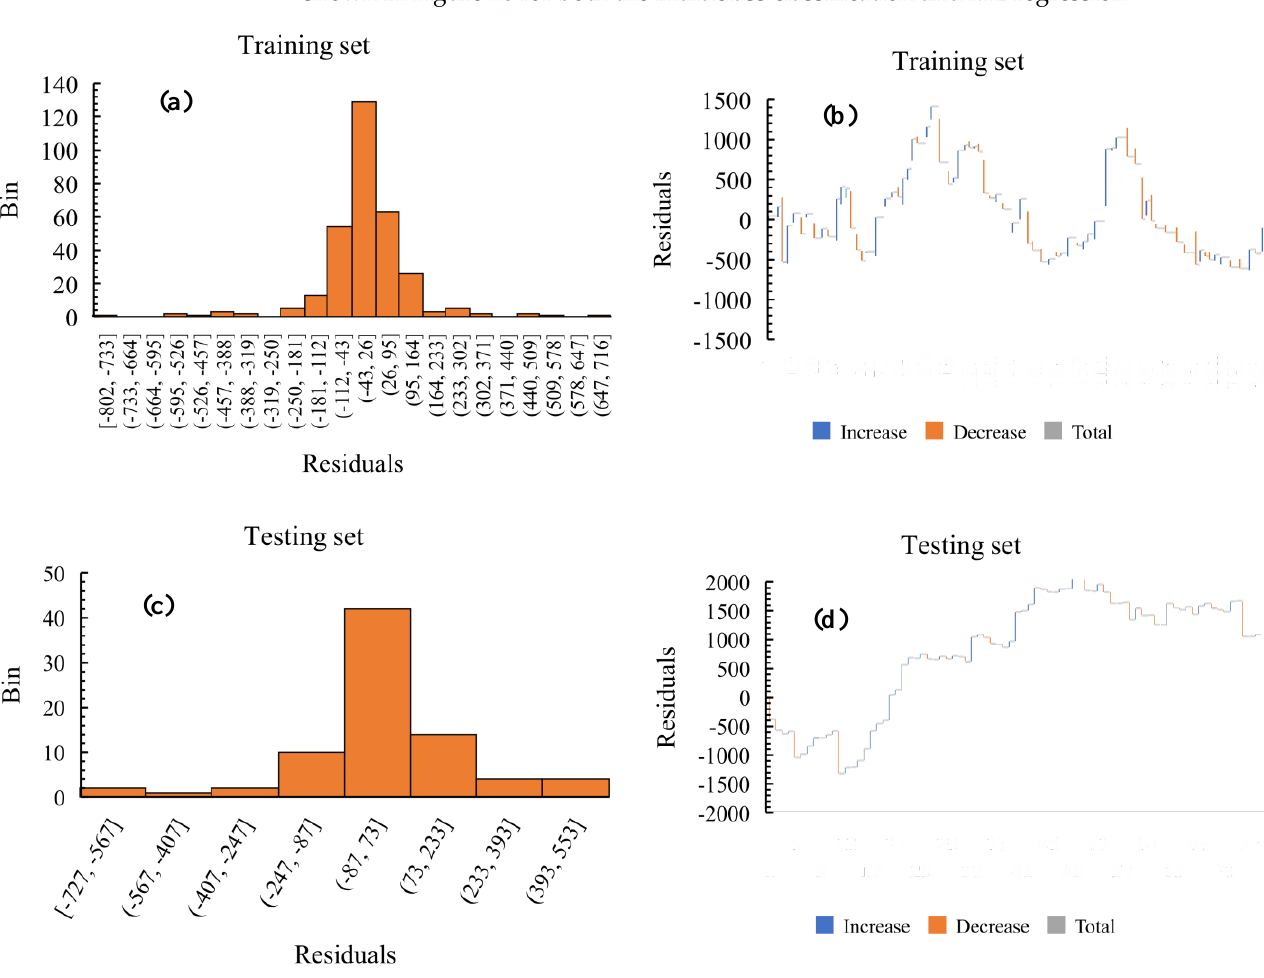
Figure 9. Distribution of residuals. ( a ) Normal distribution for training set, ( b ) cumulative curve of training set, ( c ) normal distribution for testing set, ( d ) cumulative curve of testing set.